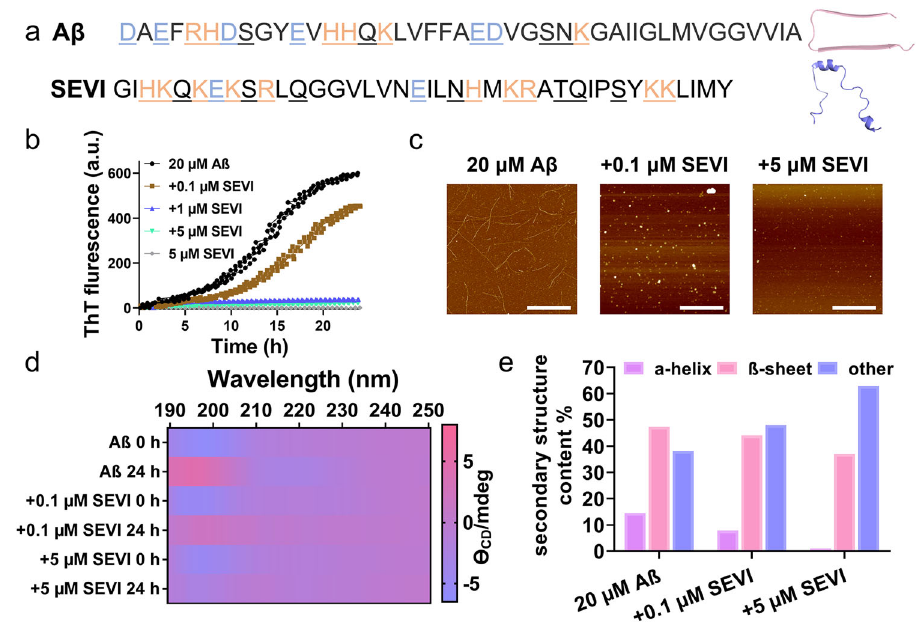
Fig. 1 Cross-seeding of SEVI with A β to induce the inhibition effect on A β aggregation. a Sequence and structure of A β with a U-bent, β -structure and SEVI with a α -helix-structure. Color ID: polar residues (underline), non-polar residues (black), positively charged residues (orange), and negatively charged residues (blue). b Dose-dependent inhibition effect of SEVI (0.1 – 5 µ M) on A β (20 µ M) aggregation by ThT fl uorescence assays. All data represent mean ± standard error of triplicate measurements. ( n = 3). c AFM images of pure A β (20 µ M) and cross-seeding A β -SEVI (20 µ M:0.1 – 5 µ M) systems at 24 h. Scale bars are 1 µ m. d Time-dependent structure transition map of A β (20 µ M) in the absence and presence of SEVI (0.1 – 5 µ M) at 0 h and 24 h. e Final secondary structure distributions of pure A β (20 µ M) and cross-seeding A β -SEVI (20 µ M:0.1 – 5 µ M) aggregates at 24